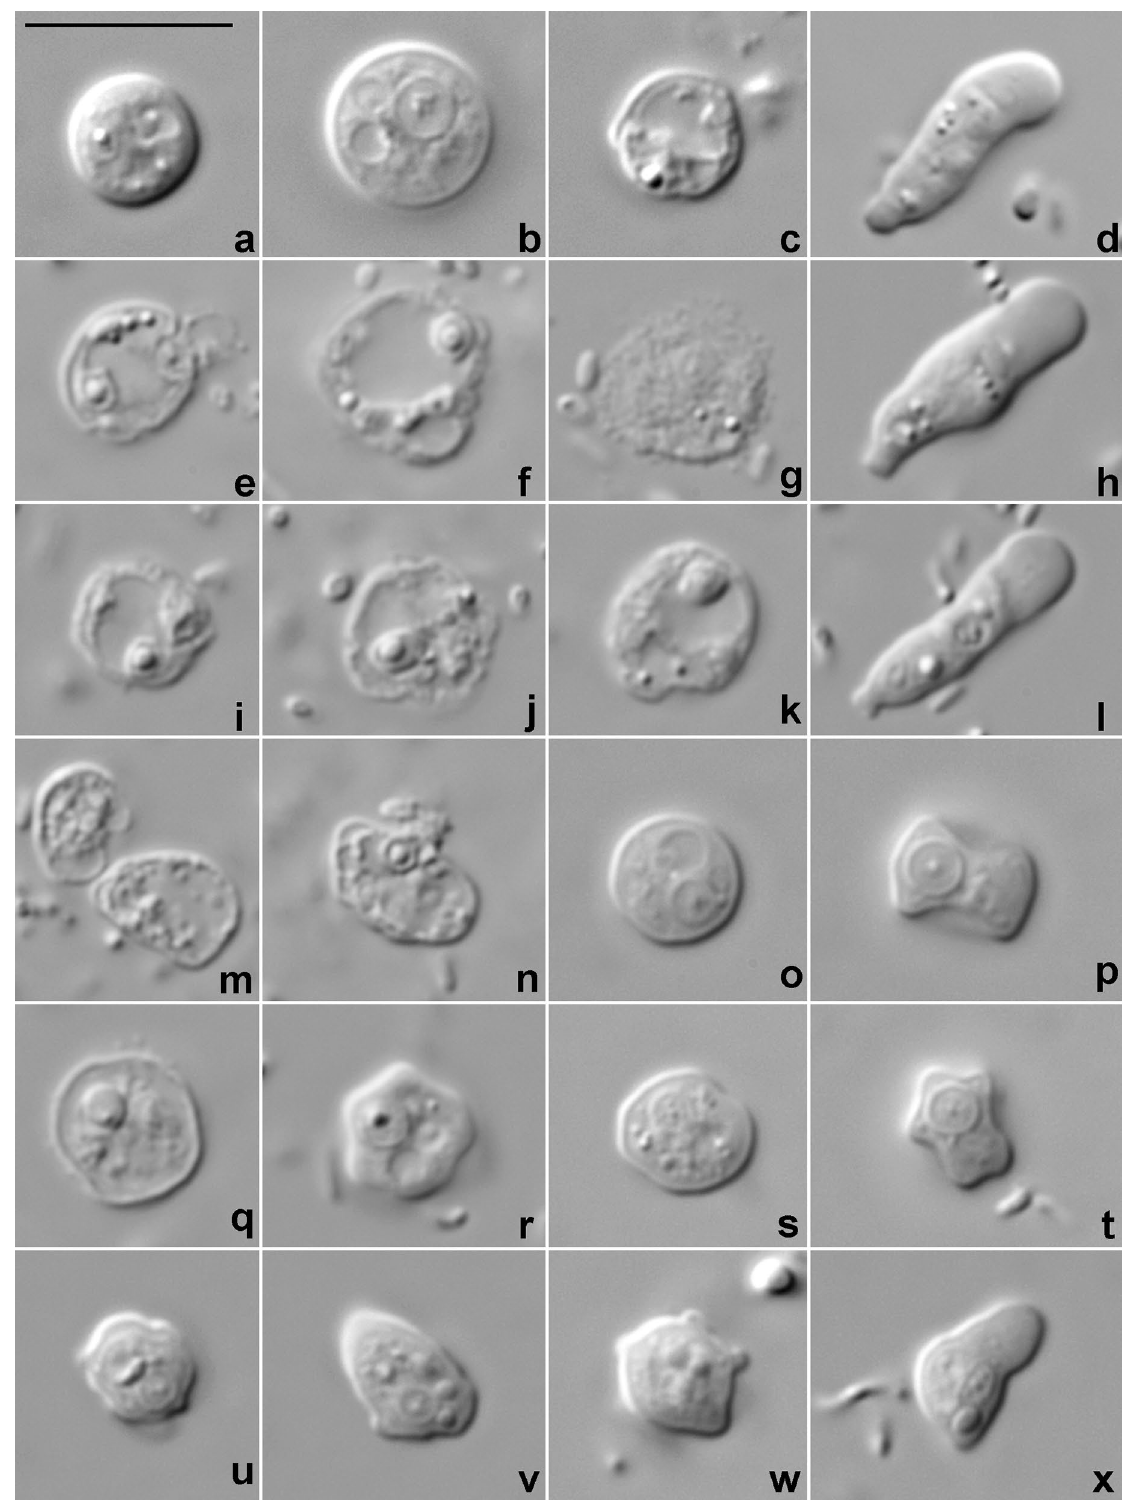
Figure 6. Light micrographs of Coronamoeba villafranca gen. nov. sp. nov. trophic cells on slides showing changes in amoeba morphology under the influence of the medium dilution. ( a – c ) Immediately after dilution to 0.3‰. ( d ) Locomotive form of a control cell in 40‰ immediately after placement on slide. ( e – g ) After 1 day of incubation in 0.3‰. ( h ) Locomotive form of a control cell in 40‰ after 1 day on slide. ( i – k ) After four days of incubation in 0.3‰. ( l ) Locomotive form of a control cell in 40‰ after 4 days on slide. ( m , n ) After 1 day of incubation in 1.25‰. ( o , p ) Immediately after dilution to 2.5‰. ( q , r ) After 1 day of incubation in 2.5‰. ( s , t ) After 3 days of incubation in 2.5‰. ( u , v ) Immediately after dilution to 5‰. ( w , x ) After 2 days of incubation at 5‰. Scale bar in a = 10 µm, valid for all